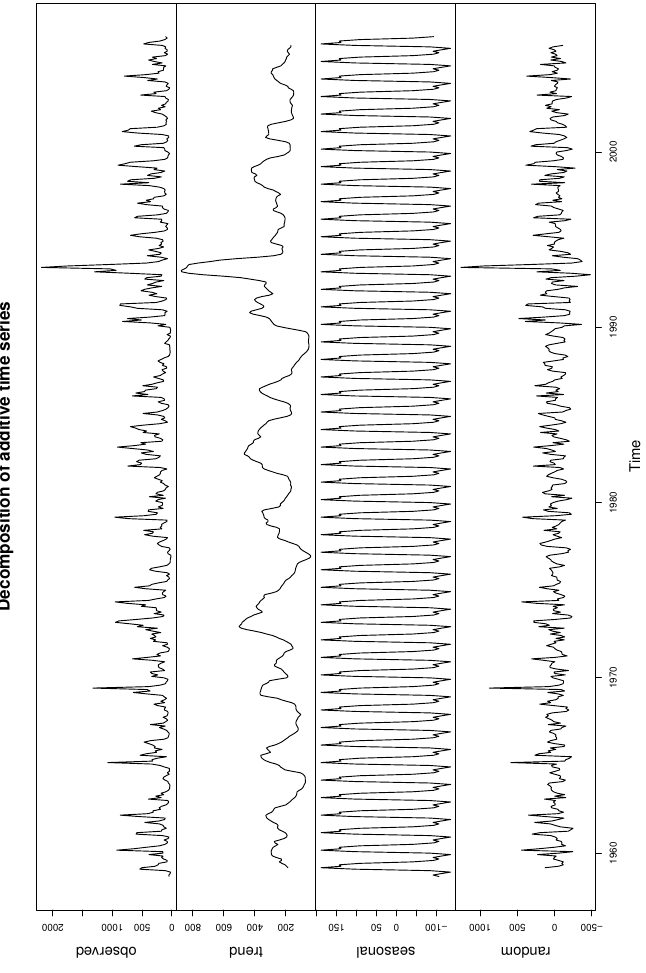
Figure 11. Decomposition of additive time series for Iowa river monthly